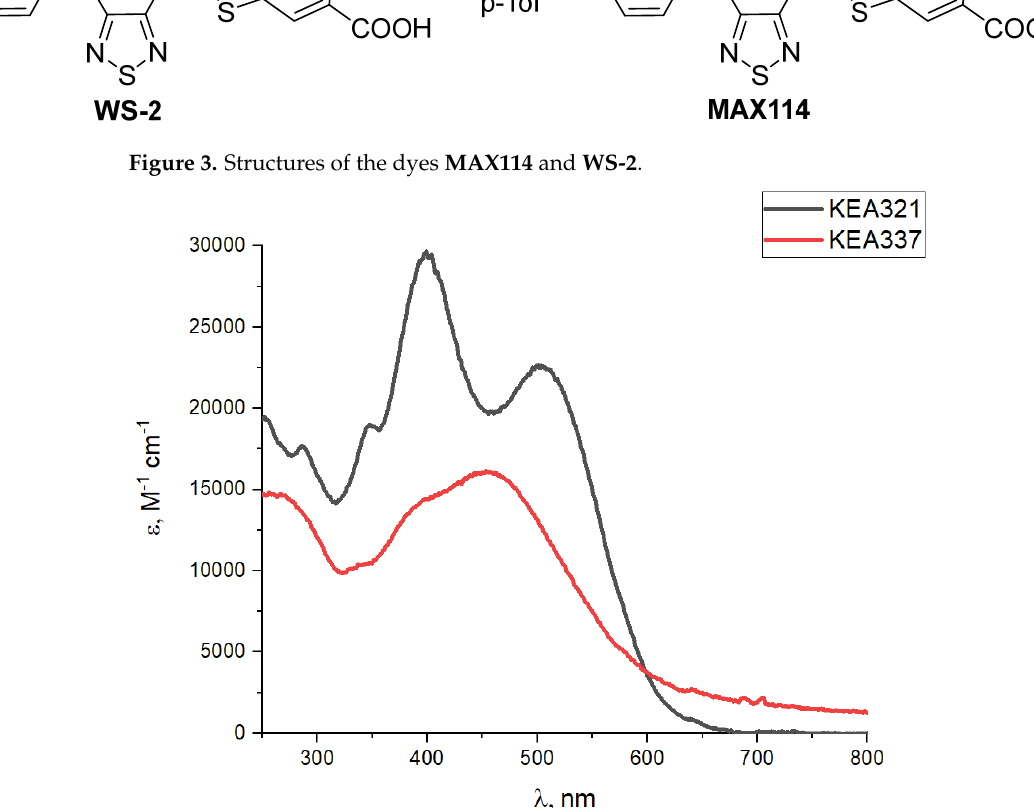
Figure 4. Absorption spectra of KEA dyes in DCM solutions (5.5 × 10 − 5 M).